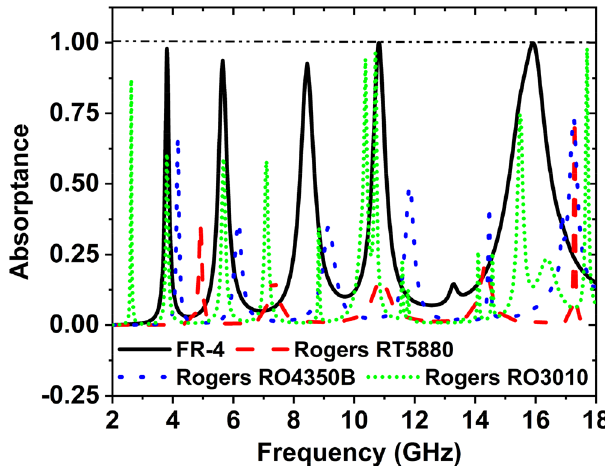
Figure 20. Effect of different substrate material on the absorption peak curve.